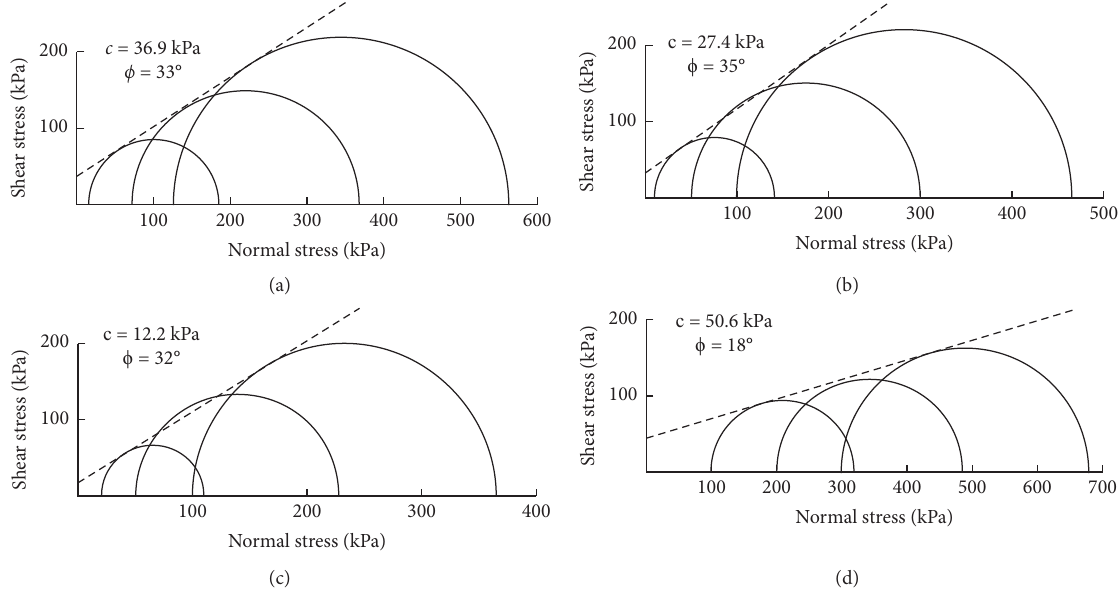
Figure 8: Strength envelope for different stress paths. (a) Stress path UU0.0. (b) Stress path UU0.5. (c) Stress path UU1.0. (d) Stress path LU ∞